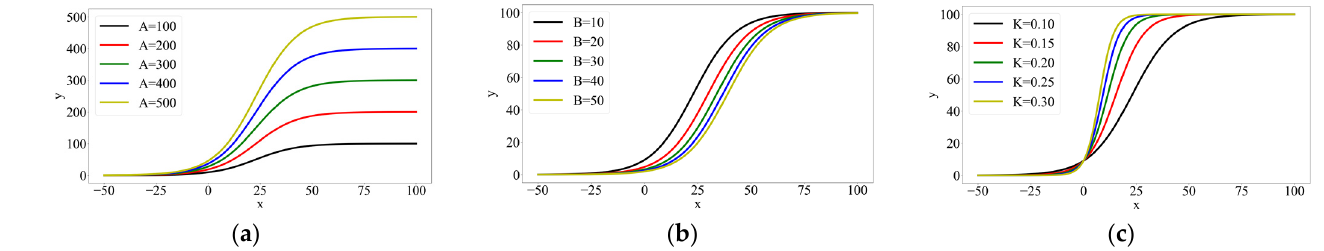
Figure 2. The influence of parameters A , B , and K on the Logistic curve. ( a ) The influence of the parameter A ; ( b ) the influence of the parameter B ; ( c ) the influence of the parameter K.